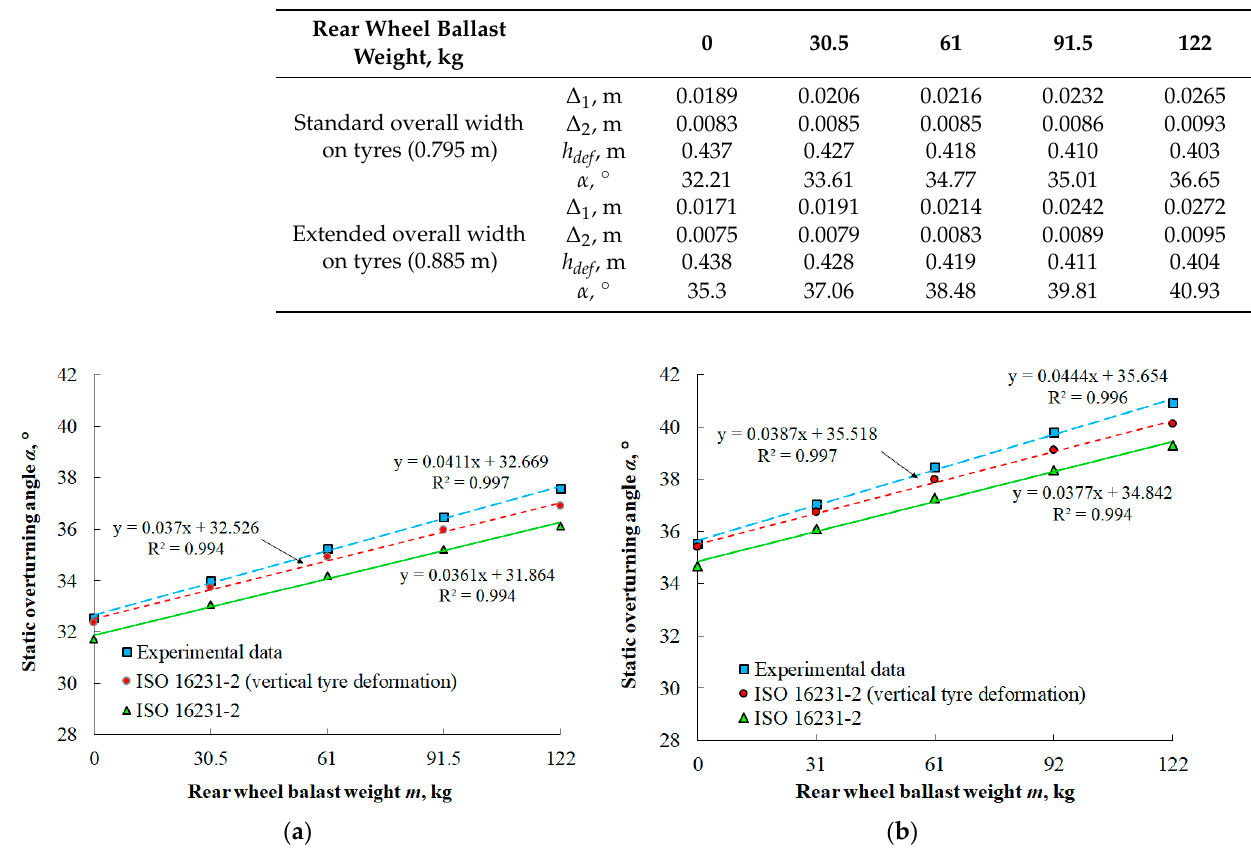
Figure 9. Influence of the vertical tyre deformation on the static overturning angle calculated according to standard [12]: ( a ) standard overall width on tyres ( o = 0.795 m), ( b ) extended overall width on tyres ( o = 0.885 m).